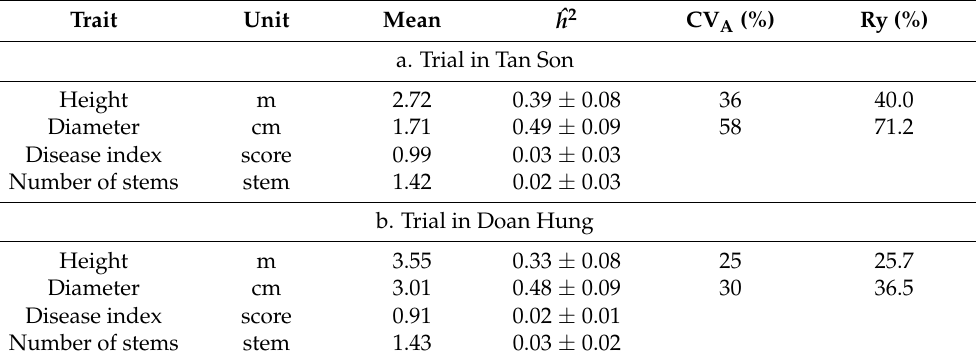
Table 3. Trial means, individual heritability, and coefficients of additive genetic variation for the studied traits of D. tonkinensis provenances.